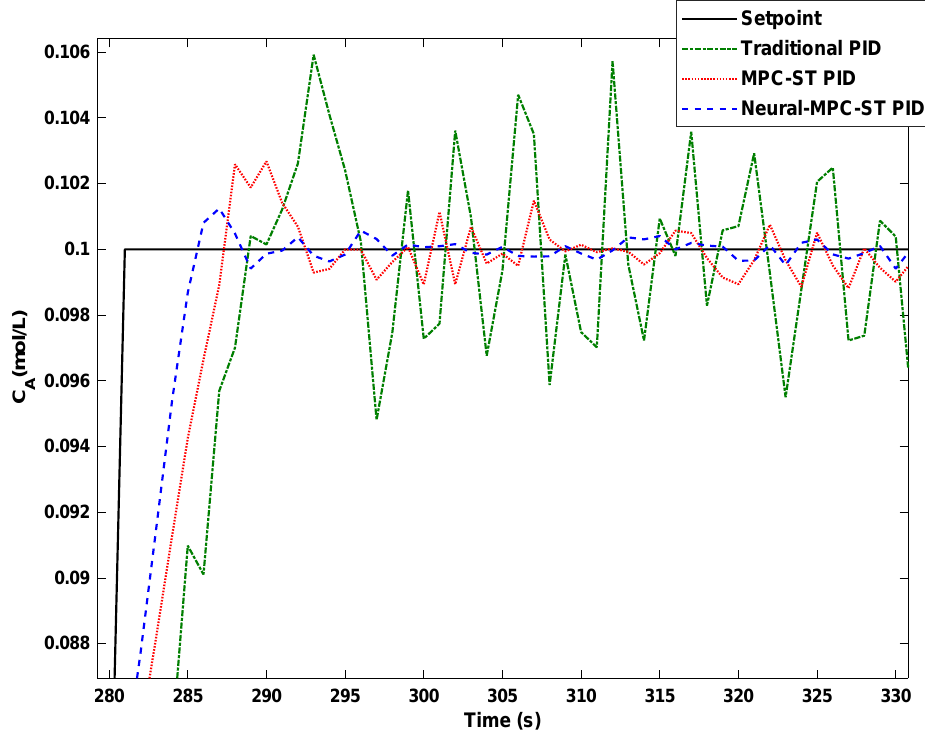
Figure 11. A closer look at a part of Figure